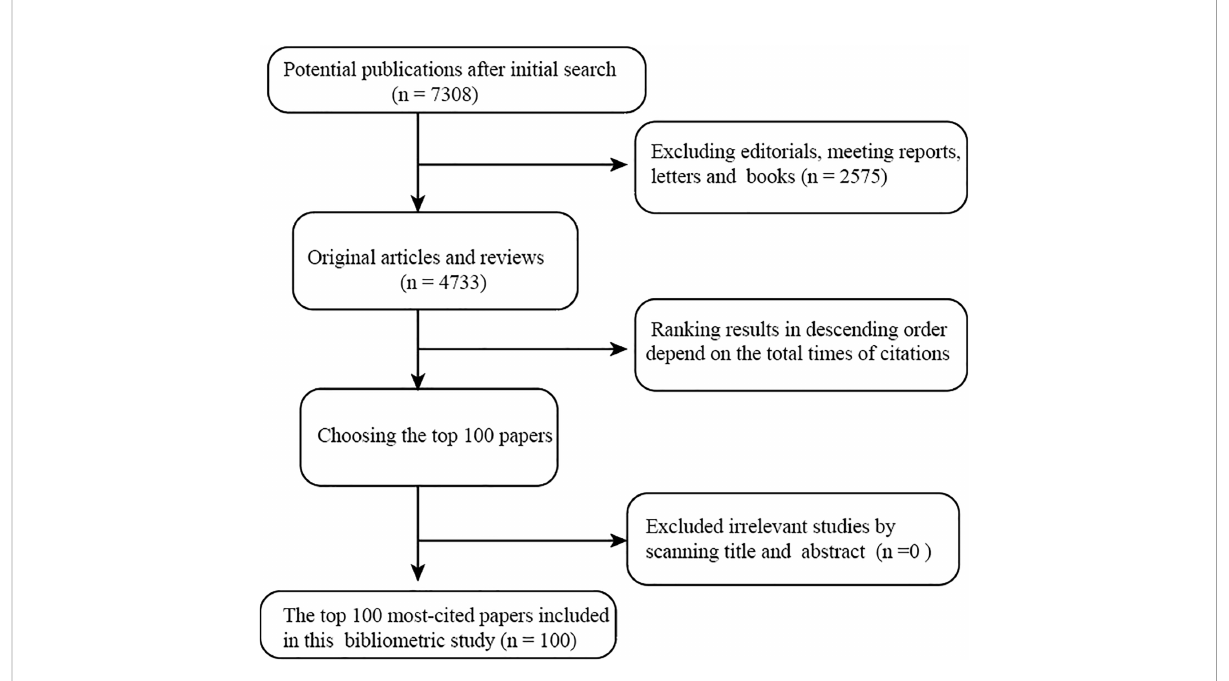
FIGURE 1 The initial search process in Web of Science